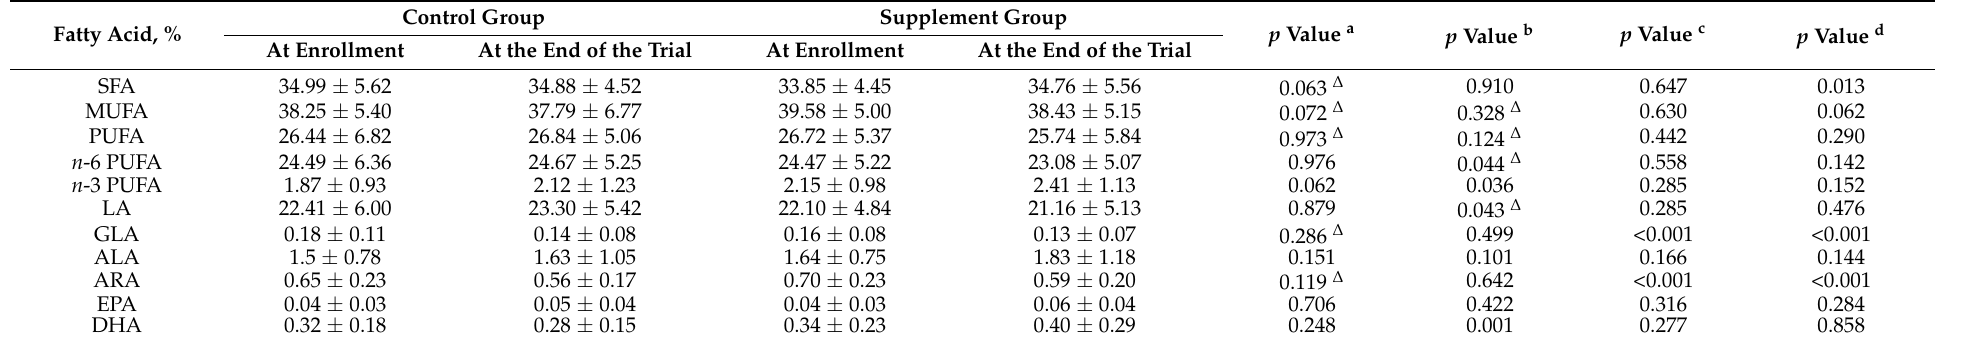
Table 4. The relative concentrations of fatty acids in breast milk between the control and supplement groups at the time of enrollment and the end of the